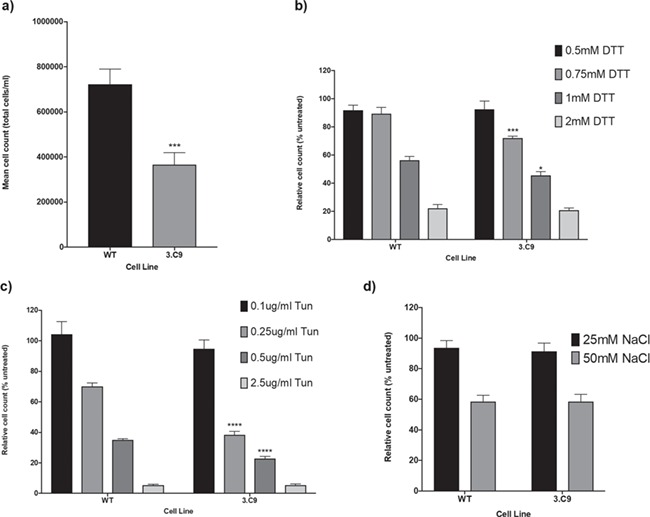
Cell line growth rates under normal and stress conditions. (a) Mean cell counts for WT HEK293 and 3.C9 cells after seeding at a density of 2.5 × 105 cells per well and growth under normal culture conditions (37°C, 5% CO2) for 48 h. n = 8. ***p-value < 0.001. (b) Relative cell counts for WT and 3.C9 cells expressed as a percentage of the cell count for untreated cells following seeding at a density of 2.5 × 105 cells per well and growth for 48 h in different concentrations of DTT. n = 8. *p-value < 0.05, ***p-value < 0.001. (c) Relative cell counts for WT and 3.C9 cells expressed as a percentage of the cell count for untreated cells following seeding at a density of 2.5 × 105 cells per well and growth for 48 h in different concentrations of tunicamycin (Tun). n = 8. ****p-value < 0.0001. (d) Relative cell counts for WT and 3.C9 cells expressed as a percentage of the cell count for untreated cells following seeding at a density of 2.5 × 105 cells per well and growth for 48 h in different concentrations of sodium chloride (NaCl). n = 8.